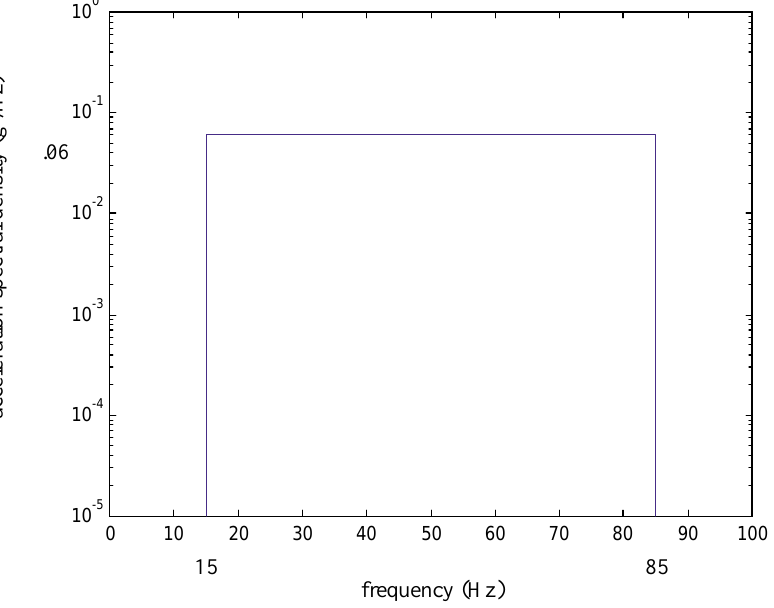
Fig. 10. Random vibration input acceleration spectrum-tri-axial shaker.